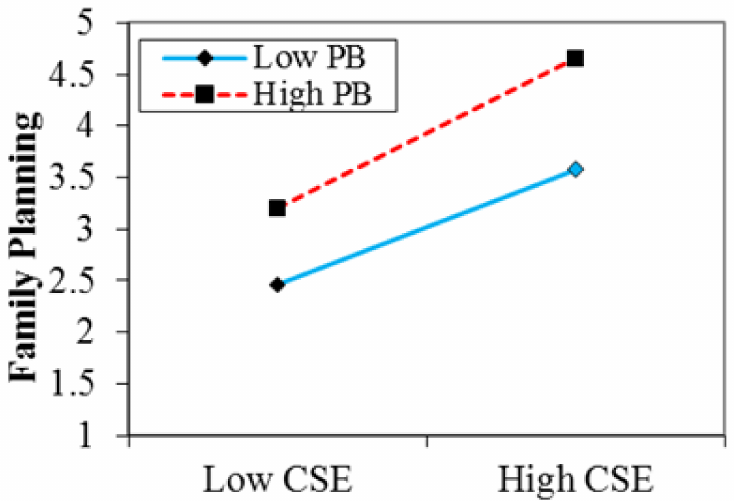
Figure 2. Interactive effect of contraceptive self-efficacy and perceived barriers on FP practices. CSE = contraceptive self-efficacy; PB = perceived